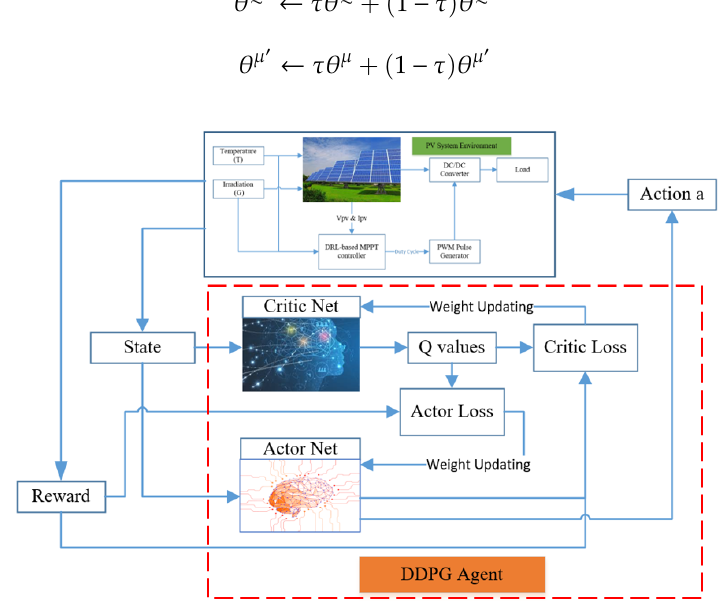
Figure 3. A diagram of the deep deterministic policy gradient (DDPG) algorithm.